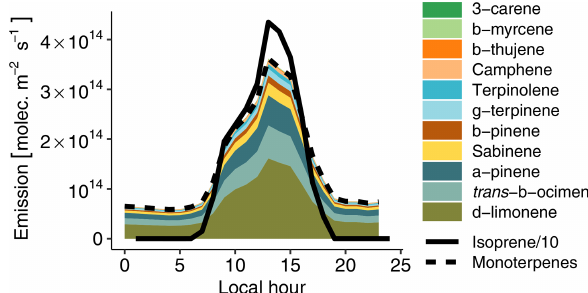
Figure 3. Hourly biogenic emissions estimated with MEGAN and scaled to match measured concentrations (see Sect. 3.2.1). The lines depict isoprene (continuous line) and total monoterpenes (dashed line). The colored areas depict the contribution of each individual species to total monoterpenes. Please note that isoprene emissions are divided by 10 to fit on the